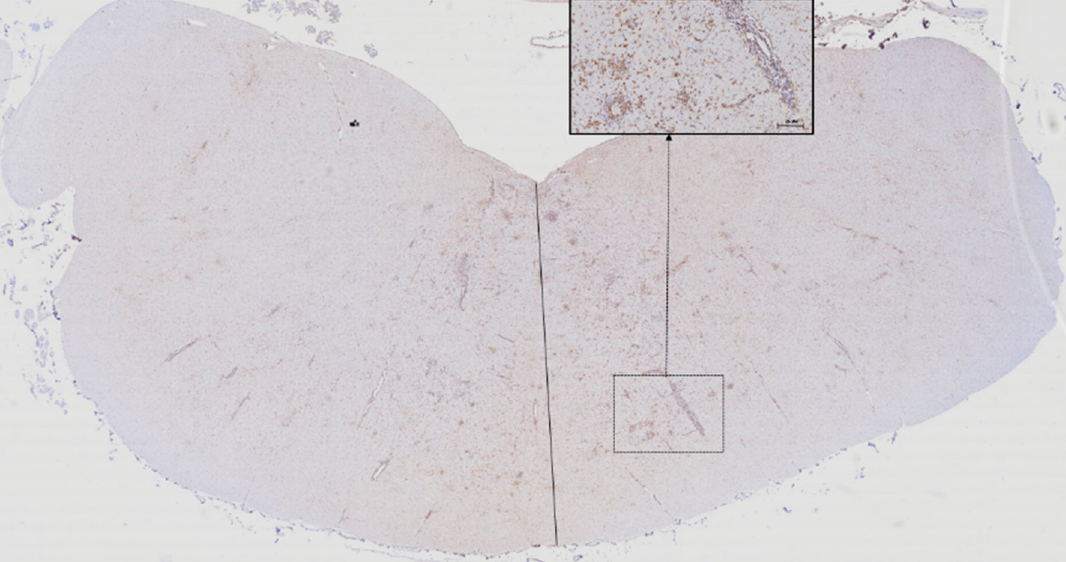
Figure 4. Complete cross-section of the medulla oblongata immunostained for microglia, showing numerous glial foci on the same side of the tissue (right side) as virus injection. Inset: detail of the affected parenchyma.